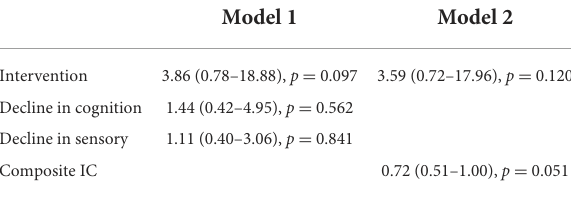
TABLE 3B Multiple logistic regression for incident